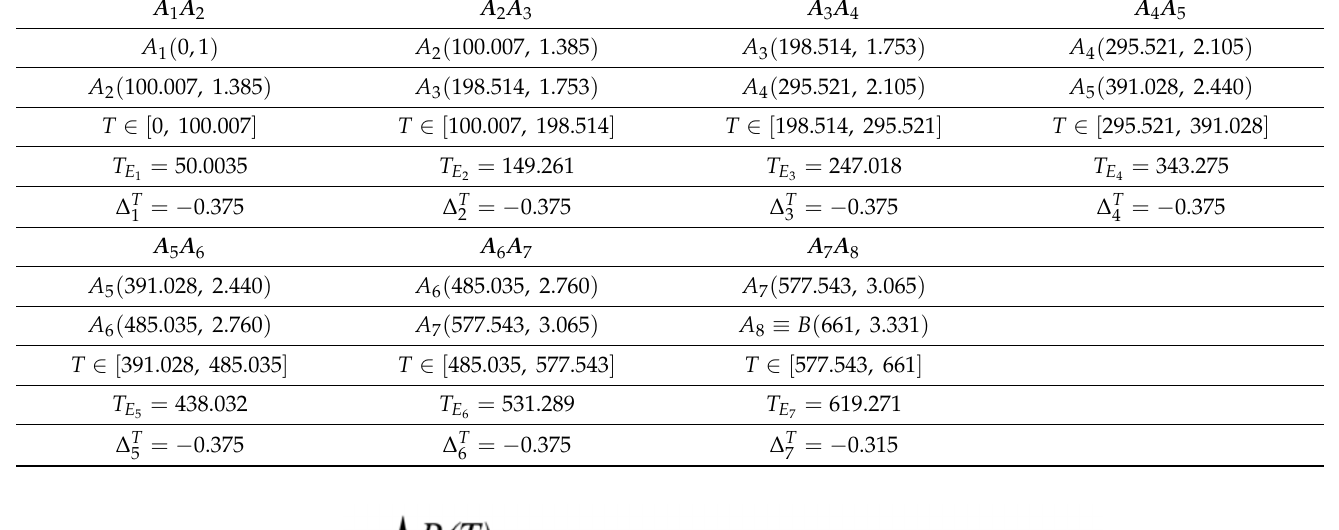
Table 2. Results in the range T ∈ [ 0, 661 ] ◦ C.